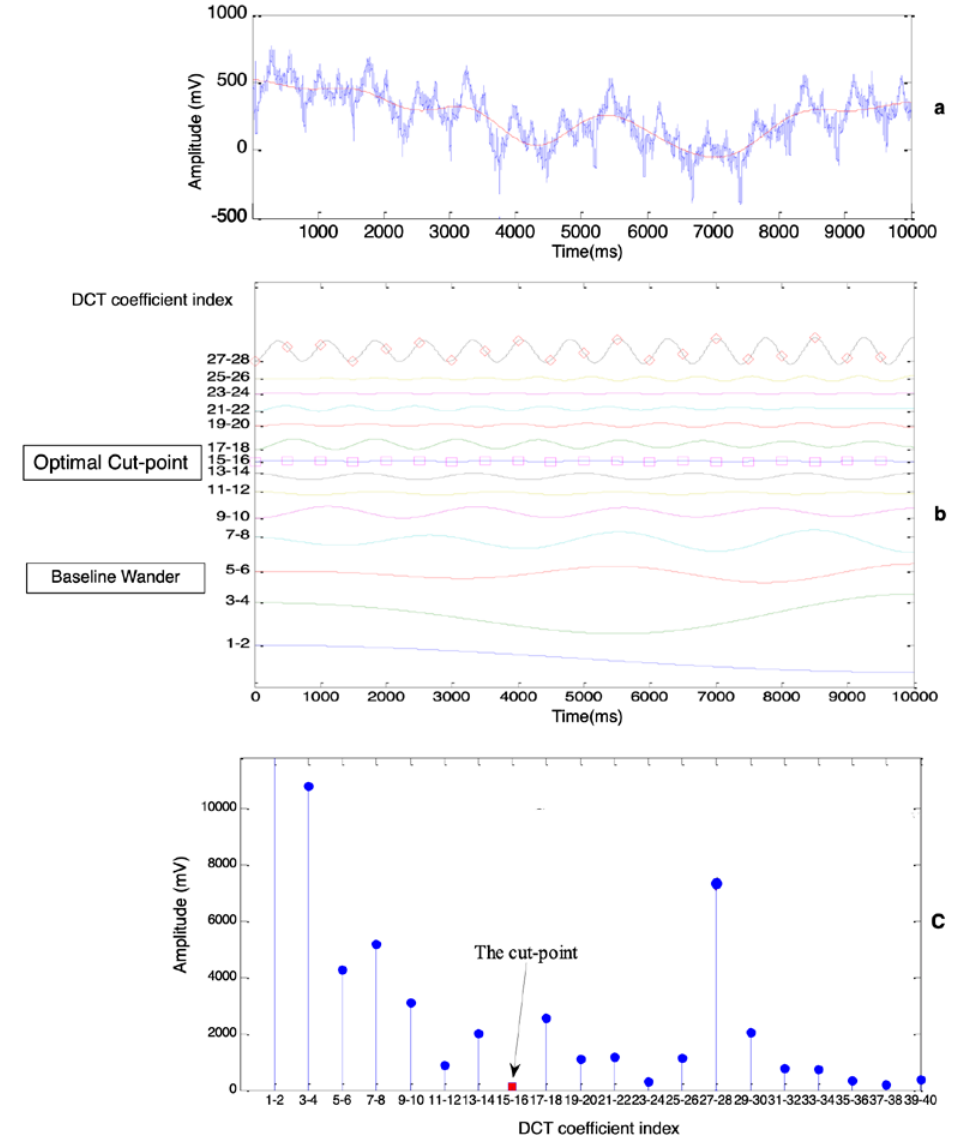
Figure 3. Determine the optimal cut-point between BW and ECG (lead AVF of PTB record pa- tient004/s0020arem). ( a ) Raw ECG signal (blue curve) and BW (red curve). ( b ) Cosine waves, each of which is generated from one DCT coefficient. ( c ) Amplitude of low-frequency components, each component is generated from two DCT coefficients.